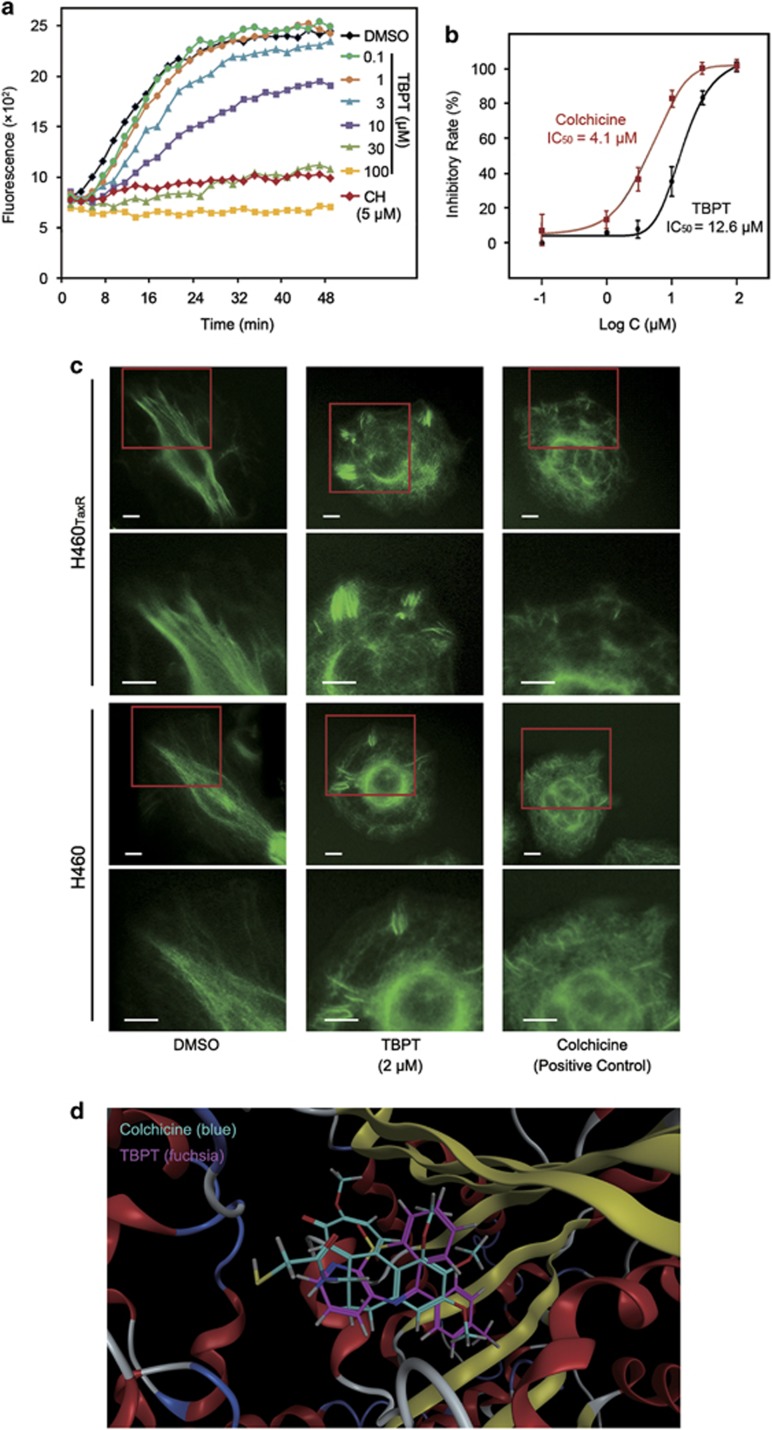
TBPT inhibited tubulin polymerization and disrupted microtubule formation. (a) The rate of the tubulin polymerization process was monitored via fluorescence in the presence of TBPT or colchicine (CH) at the indicated concentration in a cell-free system. The fluorescence was monitored every 2 min for 50 min. (b) Dose-dependent tubulin polymerization was observed. N=2. (c) After the cells were treated with DMSO, TBPT or CH for 24 h, their cellular microtubules were visualized via green fluorescence using a fluorescent secondary antibody binding specifically to anti-α-tubulin antibody. The scale bars represent 10 μm. (d) The molecular docking study of TBPT to the CH-binding site of tubulin